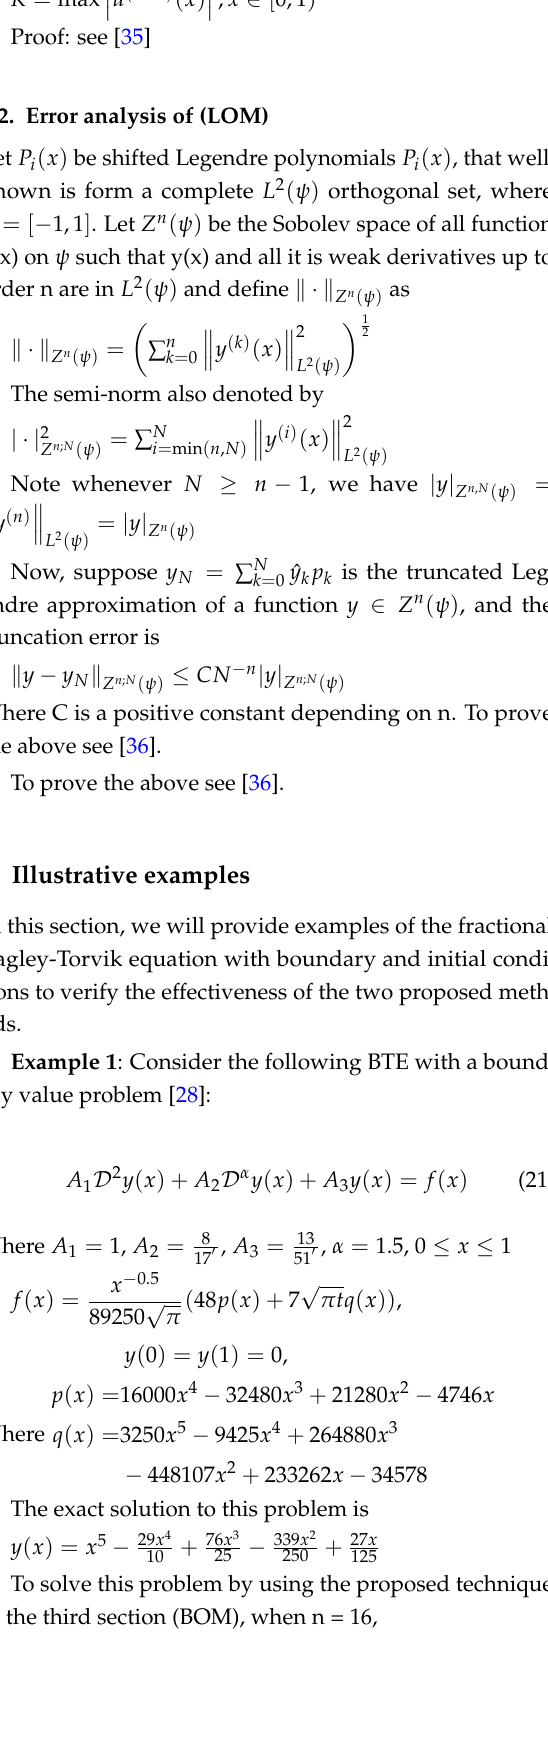
(cid:12) (cid:12) of (BOM,